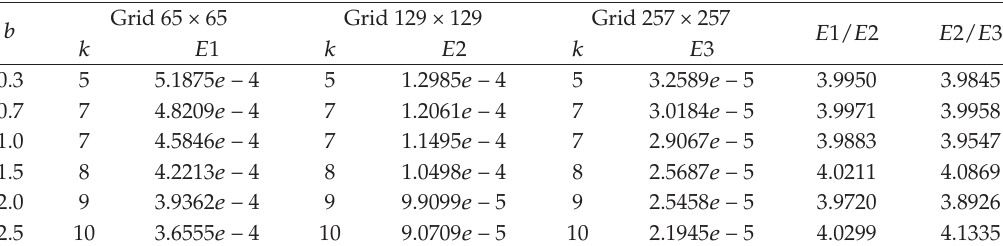
Table 5: Convergence of the method in Example 4.4 for a (cid:10) 0 .